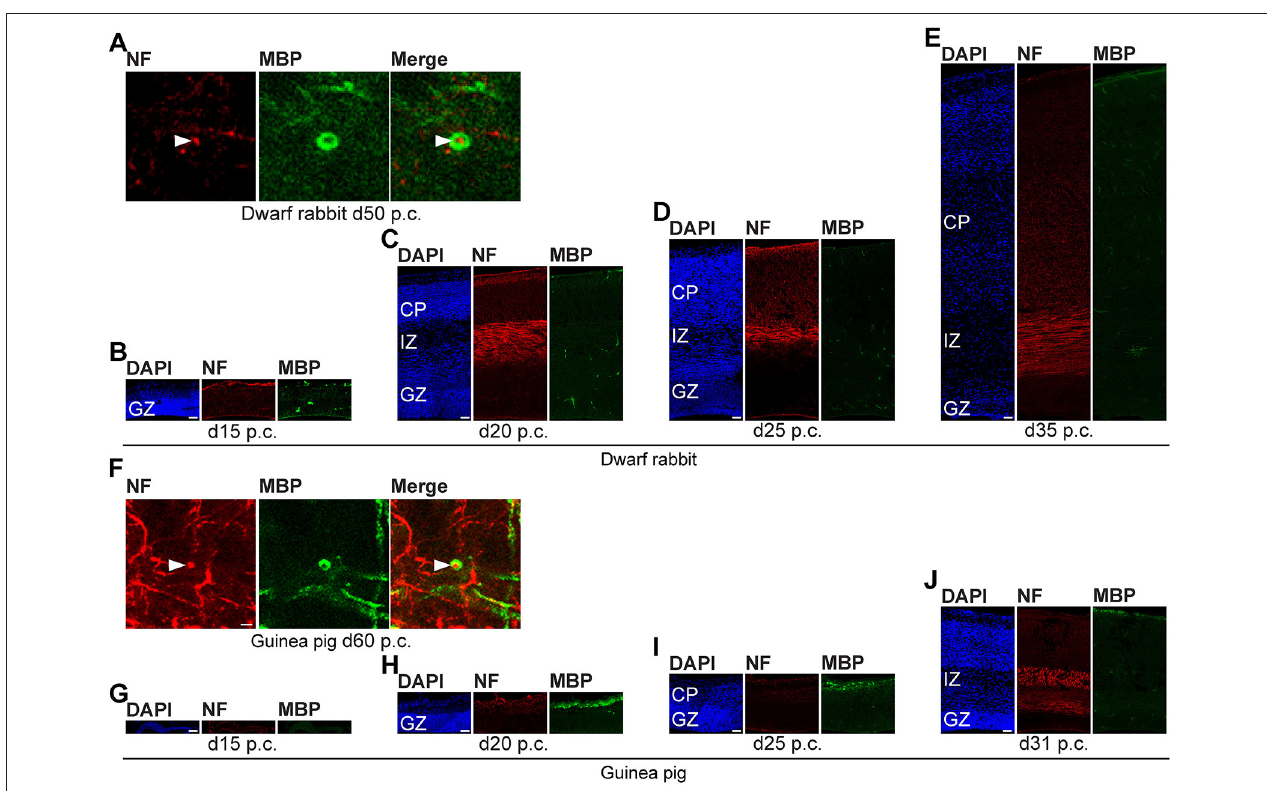
FIGURE 8 | Neurofilament H and MBP expression in the developing dwarf rabbit and guinea pig neocortex. (A–J) Double immunofluorescence for neurofilament H (NF, red, A–J ) and MBP (green, A–J ) and DAPI staining (blue, B–E,G–J ) on 30- µ m cryosections of day 15–35 post-conception (p.c.) dwarf rabbit neocortex and d15–31 p.c. guinea pig neocortex. Images in (A,F) show NF + extension (solid arrowhead) surrounded by MBP + myelin sheath in higher magnification of d50 p.c. dwarf rabbit neocortex (A) and d60 p.c. guinea pig neocortex (F) . Merge images in (A,F) show combined immunofluorescence of NF and MBP. CP, cortical plate. GZ, germinal zone. IZ, intermediate zone. Scale bars, 2 µ m (A,F) or 50 µ m (B–E,G–J) .